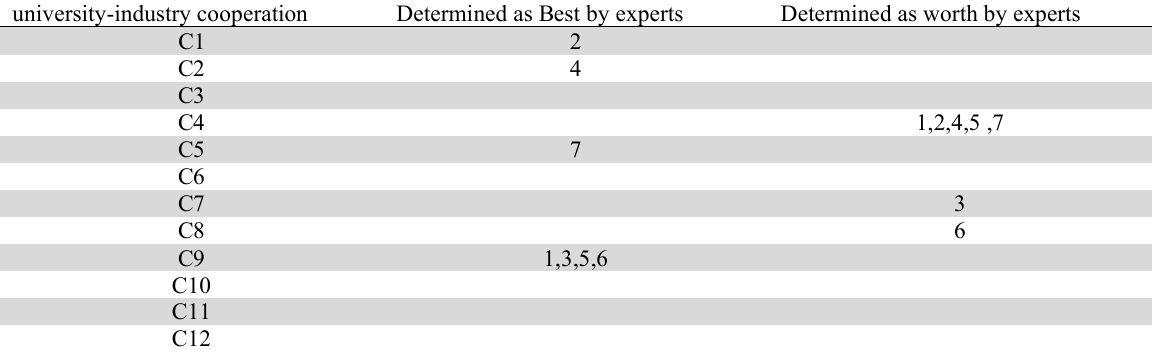
Best and Worst identified by experts